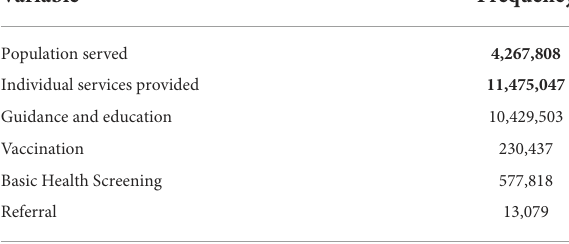
TABLE 1 Individual services provided in VDS and UMS by type of service, January 2020–July 2021.